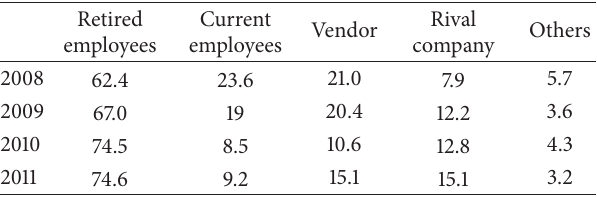
Table 4: Sources of SMB industrial technology leakage (multiple responses,